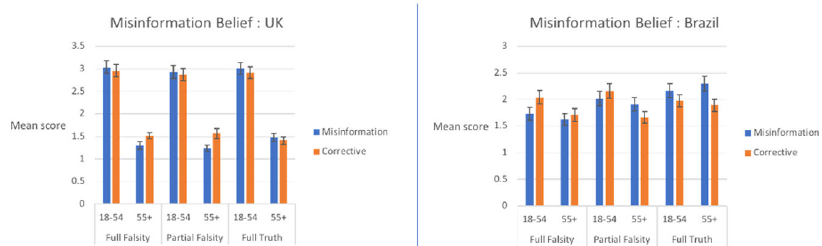
Fig. 3 Misinformation belief. Mean misinformation belief scores across misinformation types and exposures in the UK